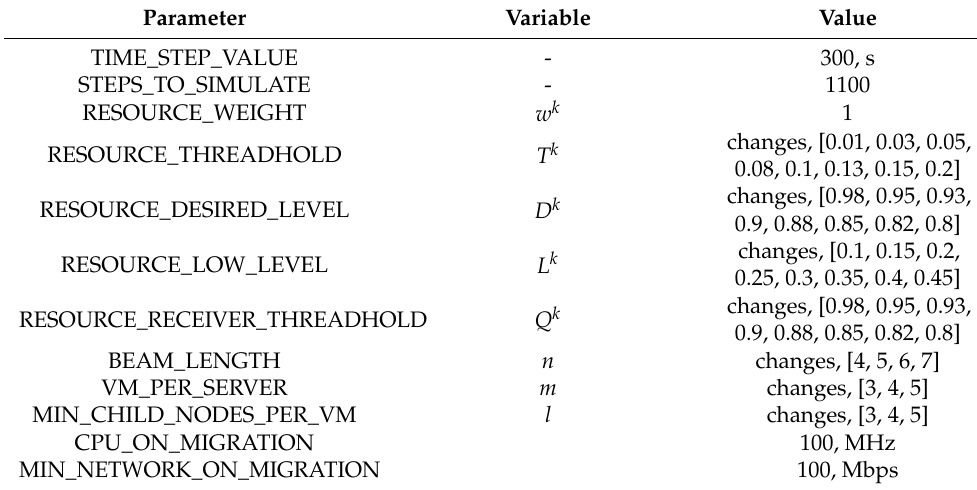
Table 2. Simulation